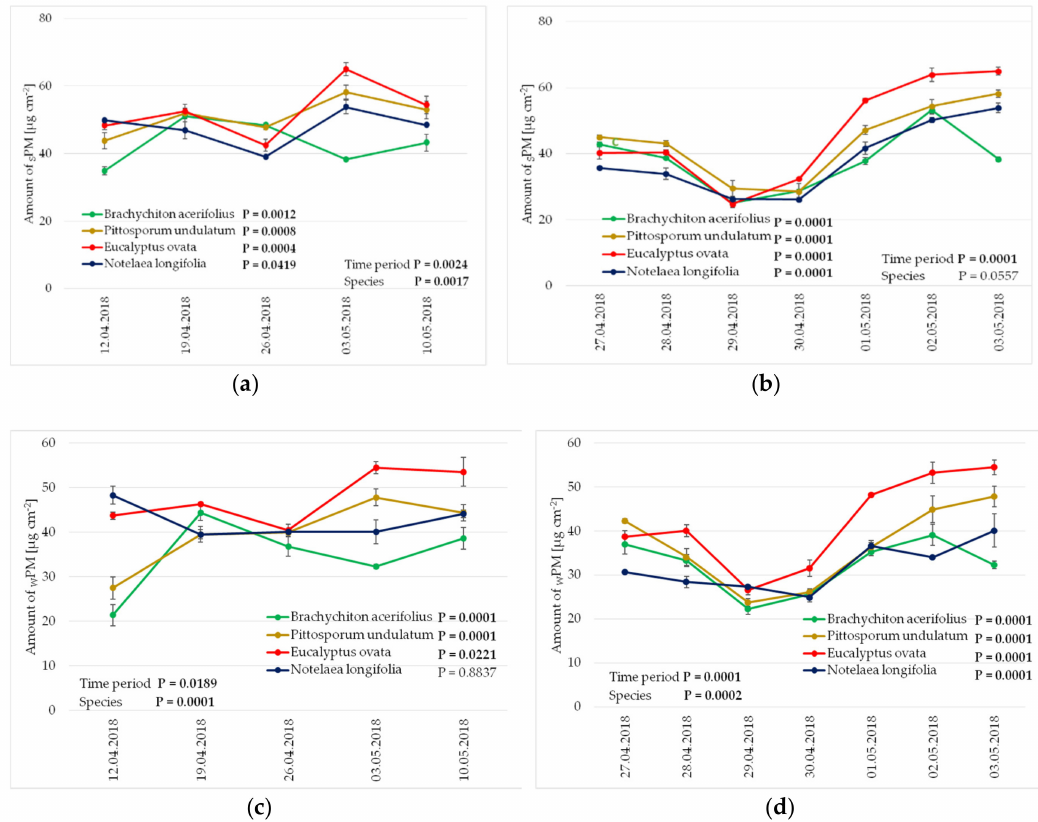
Figure 6. Amount of S PM in ( a ) a five-week period and ( b ) a seven-day period, and W PM in ( c ) a five-week period and ( d ) a seven-day period on leaves of B. acerifolius, P. undulatum , E. ovata and N. longifolia during measurement period. Data are means ± SE, n = 3. P values in bold indicate statistical